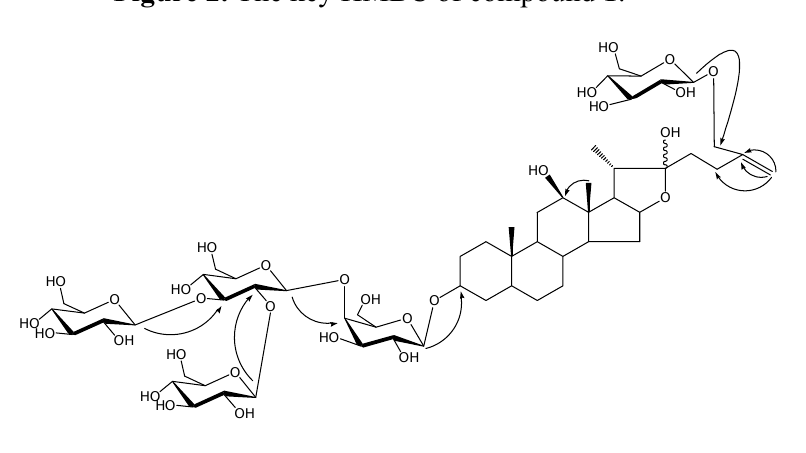
Figure 2. The key HMBC of compound 1